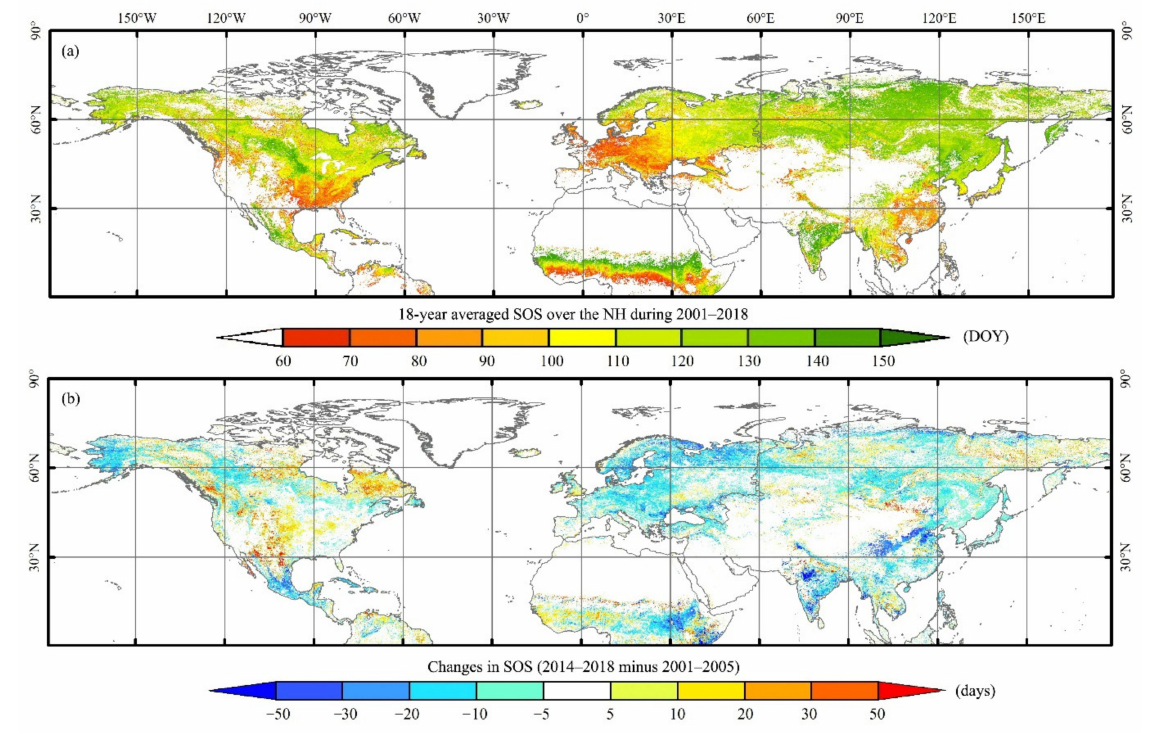
Figure 3. The 18-year ( a ) averaged SOS over the NH stable vegetated landmass over the NH derived from the MCD12Q2-C6 for 2001–2018 and ( b ) changes.